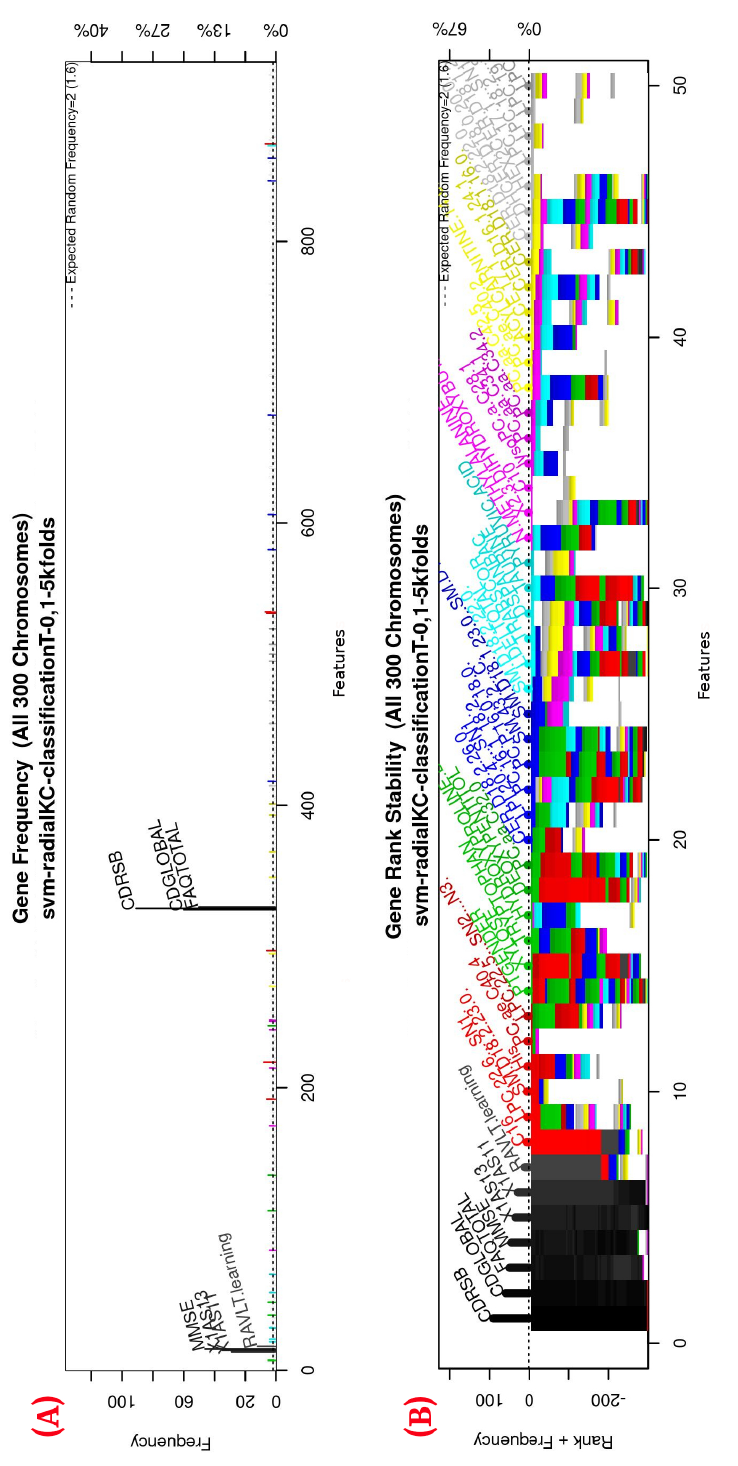
Figure A1. Gene frequency and rank in the models determined by implementing GA using the parameters in Table 3 for the selection of the top features in the dataset. ( A ) Gene frequency shows the number of times that a feature has been present in the models. ( B ) Gene rank shows the stability and frequency of each feature within the models, ordered by